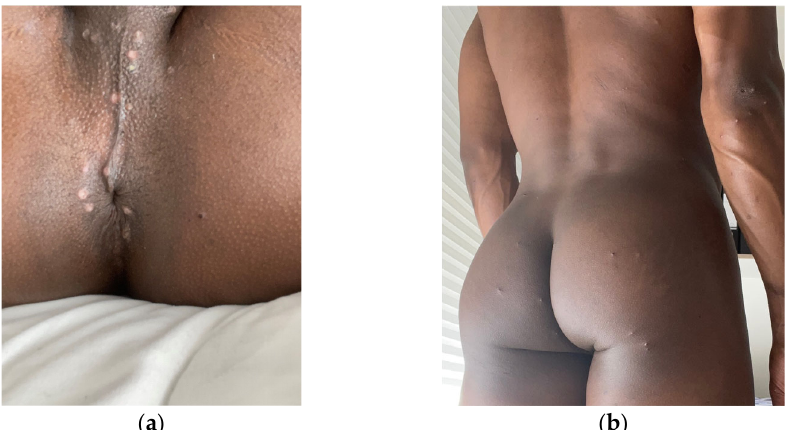
Figure 1. ( a ) Papular and vesicular skin lesions affecting the anal and perineal region. ( b ) Singular papules, vesiculae or pustules on glutes and arms.